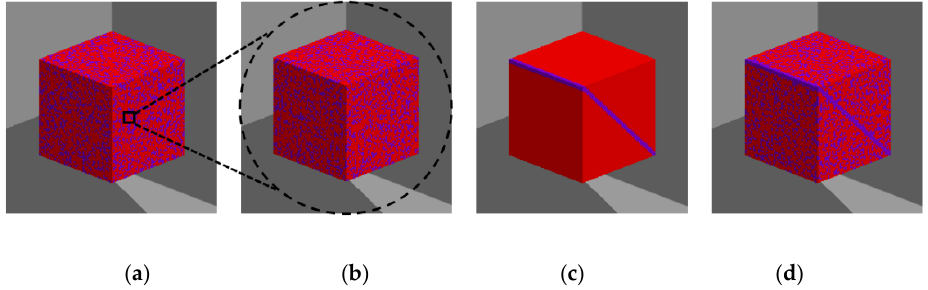
Figure 1. The reconstruction of digital rocks with different fractures: ( a ) original system; ( b ) random system; ( c ) fracture system; and ( d ) final system.